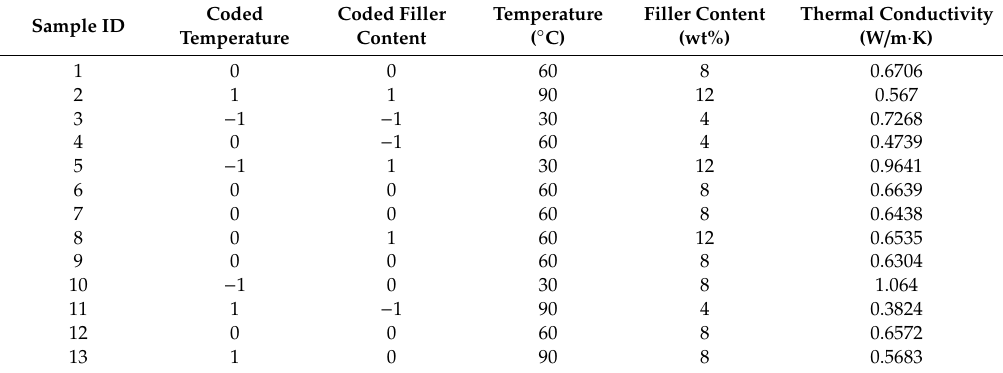
Table 3. Randomized experimental results obtained according to face-centered central composite design (FCCD).